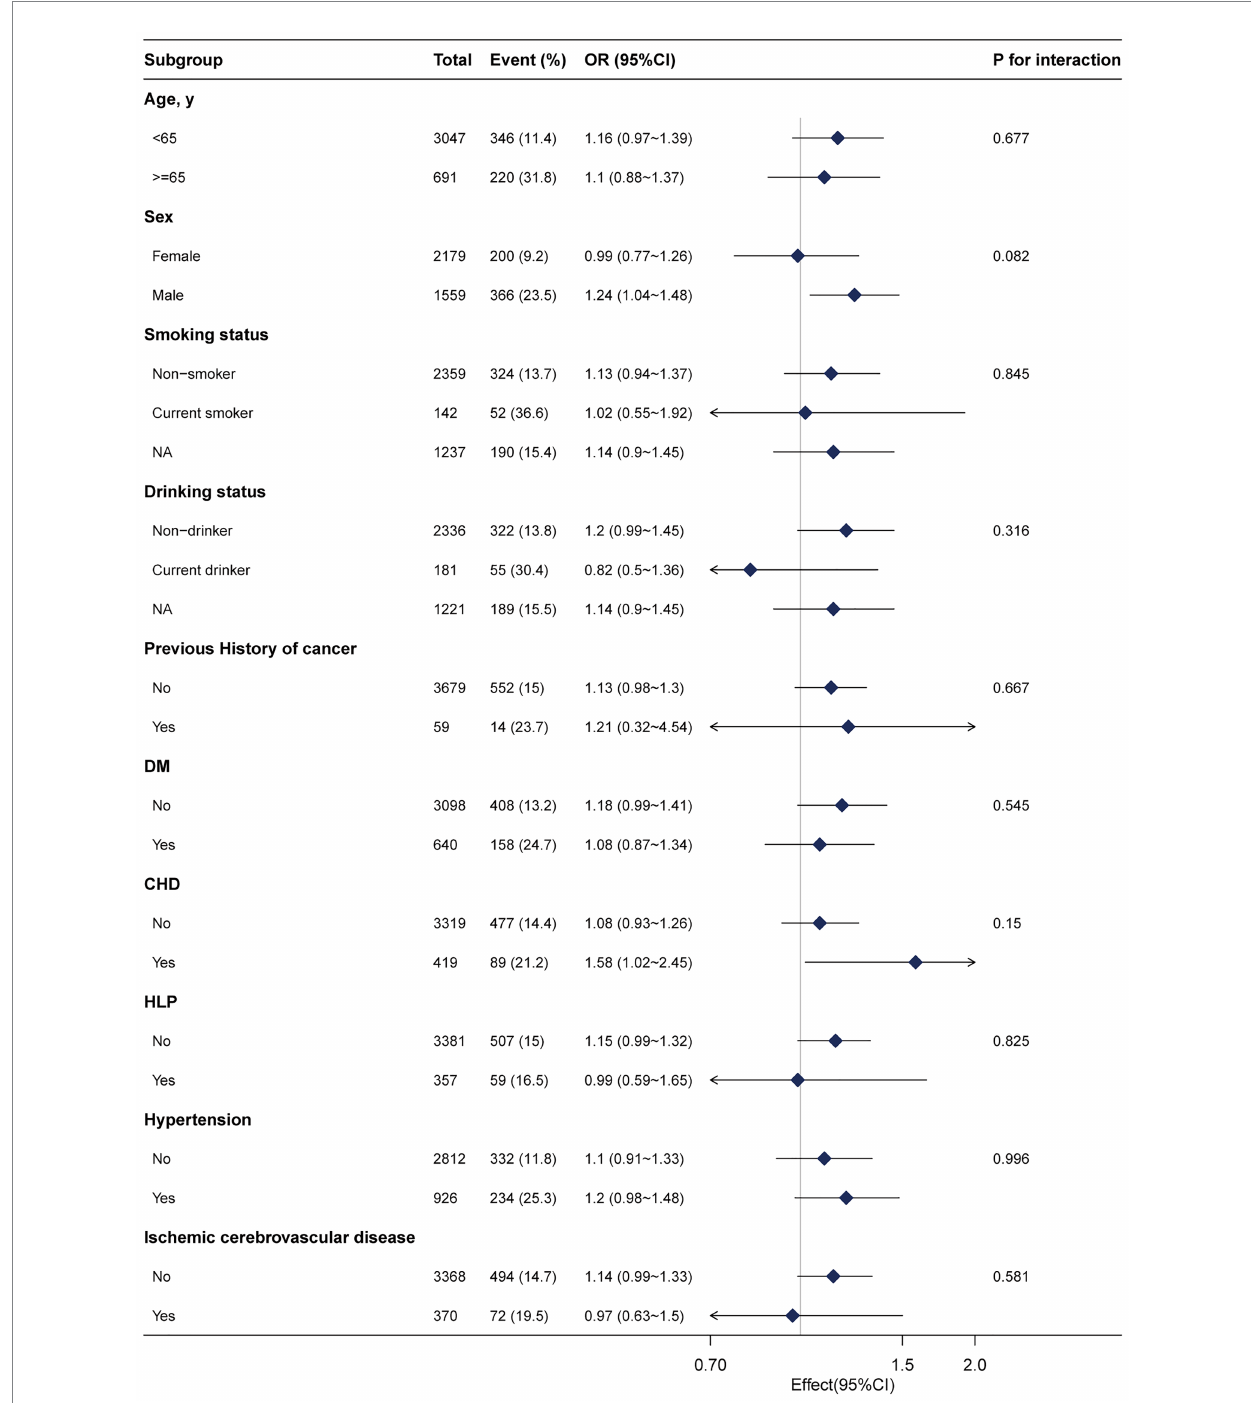
FIGURE 3 Subgroup analyses of the fibrinogen and advanced colorectal adenoma among inpatients. Except for the stratification component itself, each stratification factor was adjusted for age, sex, albumin, alkaline phosphatase, creatinine, platelets, activated partial thromboplastin time, hypertension, and diabetes mellitus. NA, not